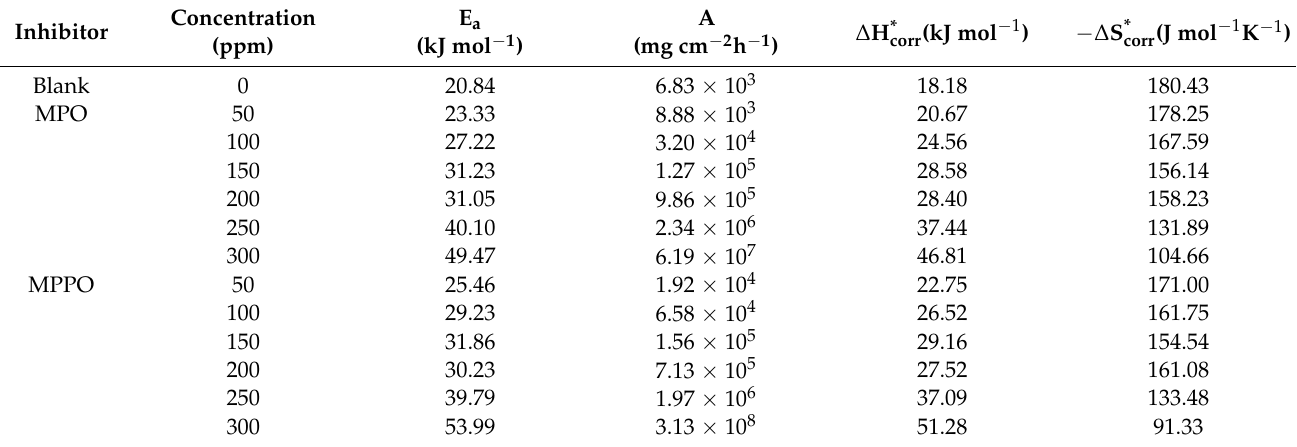
Table 2. Activation parameters for the corrosion of N80 steel in 1M HCl at various concentrations of morpholinyl Mannich base